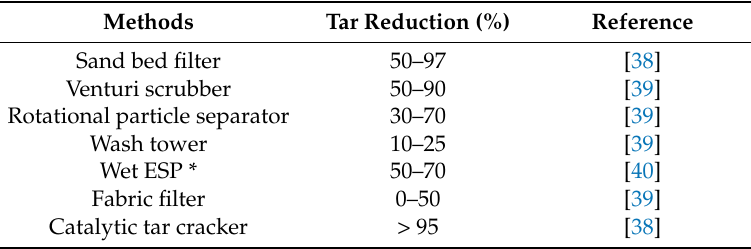
Table 7. Comparison with other tar-reduction